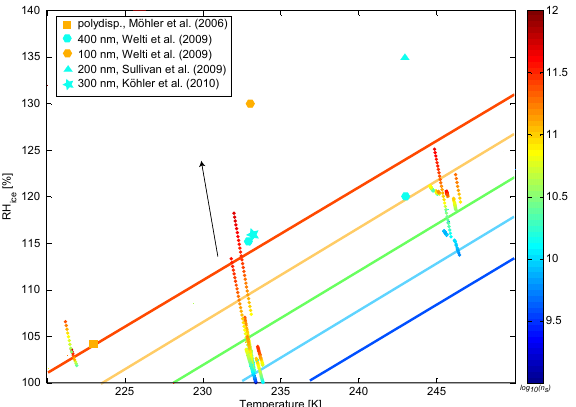
110 Figure 8. Comparison between ice nucleation active surface site densities derived from this work (colored lines), the dust-adapted parameterization by Phillips et al. (2012) (colored dashed lines) and the parameterization by Meyers et al. (1992) (black dashed line); for the Phillips parameterization, colors indicate the same temperatures as for our parameterization, whereas the Meyers parameterization is not temperature dependent ( A aer = 2 × 10 − 6 m 2 m − 3 ) – the grey dashed line indicates the upper limit for n s values derived from ex- pansion experiments presented in this